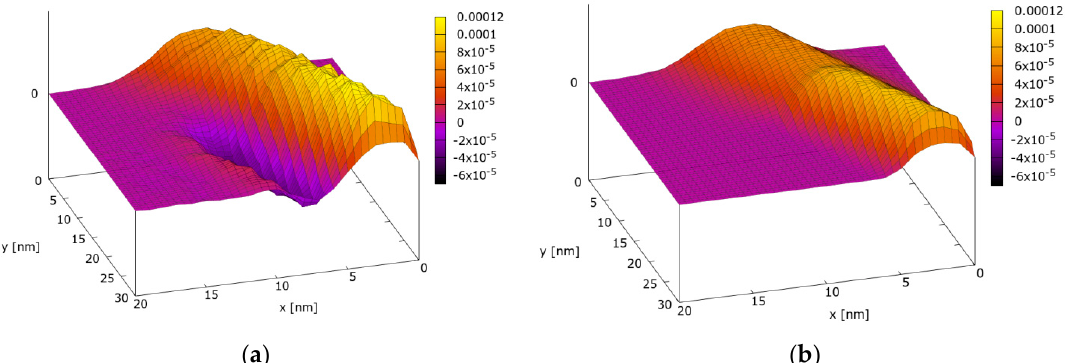
Figure 4. Comparison between quantum and classical phase-space distribution in the point ( k x1, k y1 ) = ( − 0.26 nm − 1 , 0.89 nm − 1 ): ( a ) quantum Wigner distribution, ( b ) corresponding classical Boltzmann distribution.